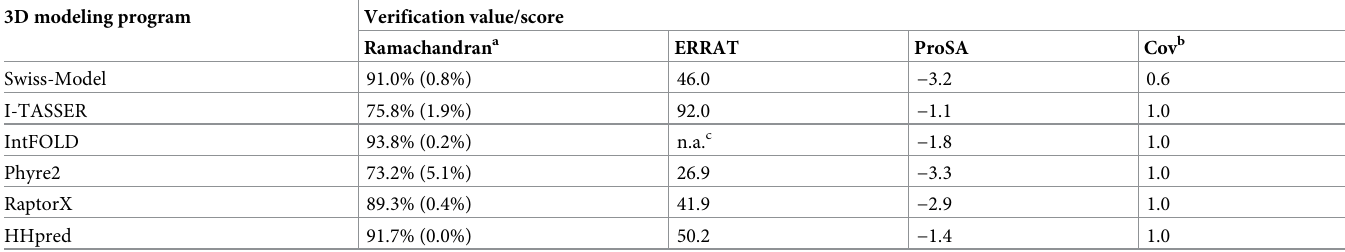
Table 1. Quality verifications of initial models of IF-CsSBAT according to different programs.